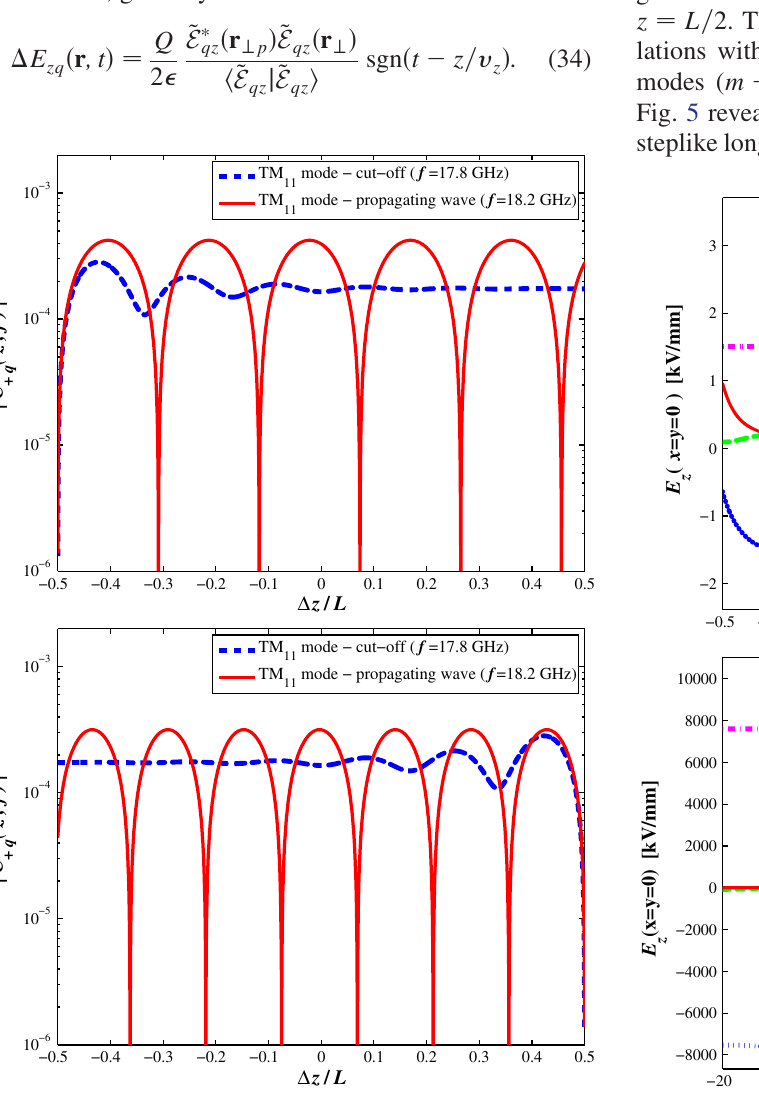
FIG. 5. (Color) Longitudinal electric field (31) obtained with a mode 11 mode (top) and with 5050 TM m;n modes single TM 11